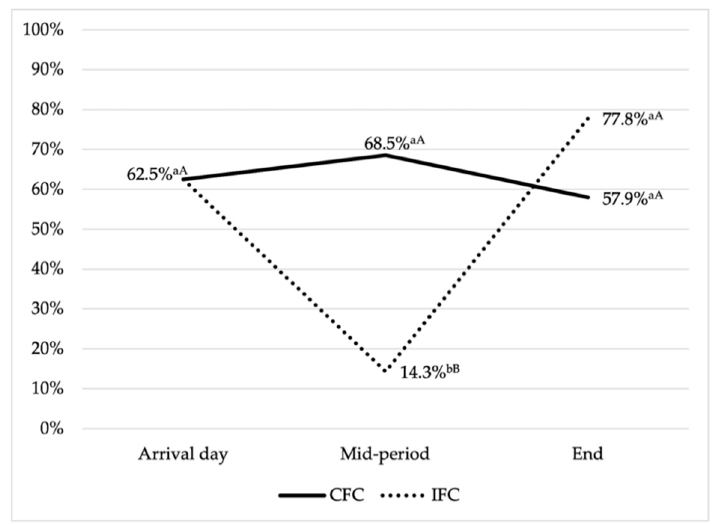
Figure 2. Multidrug-resistant E. coli isolates dynamic for commercial (CFC) and improved farm conditions (IFC) throughout the growing period. a,b : Different superscripts means significant differences within group with a p -value < 0.05. A,B : Different superscripts indicate significant differences between groups with a p -value < 0.05.